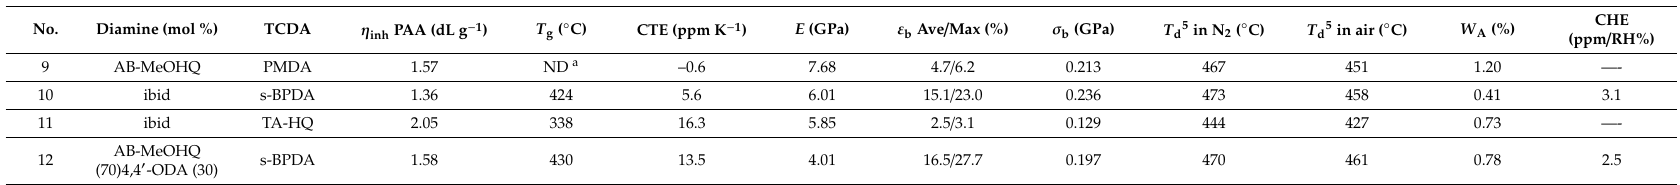
Table 3. Film properties of the PEsIs derived from AB-MeOHQ (R = –OCH 3 ) with tetracarboxylic dianhydrides (TCDA) and related copolymer.